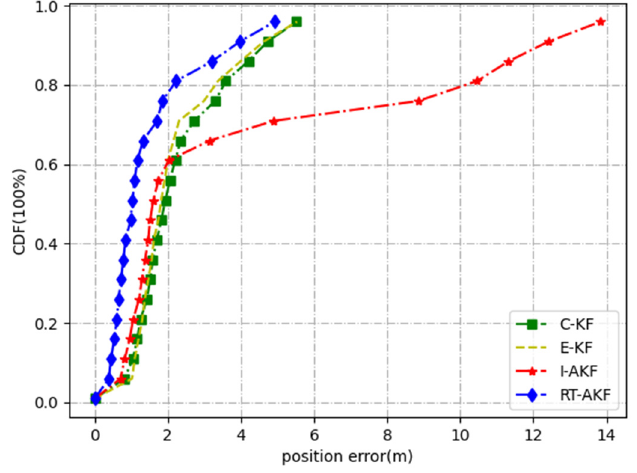
Figure 11. Accuracy comparison by different methods in segment #3.